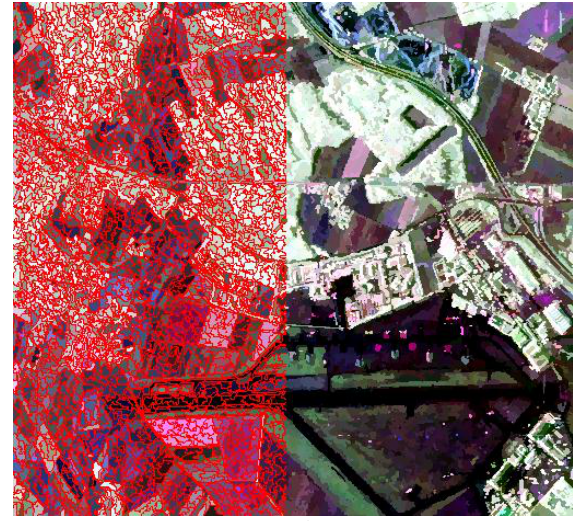
Figure 5. Segmentation result of GSRM-BPT using the NoR- based pruning strategy Algorithm P-BPT GSRM-BPT